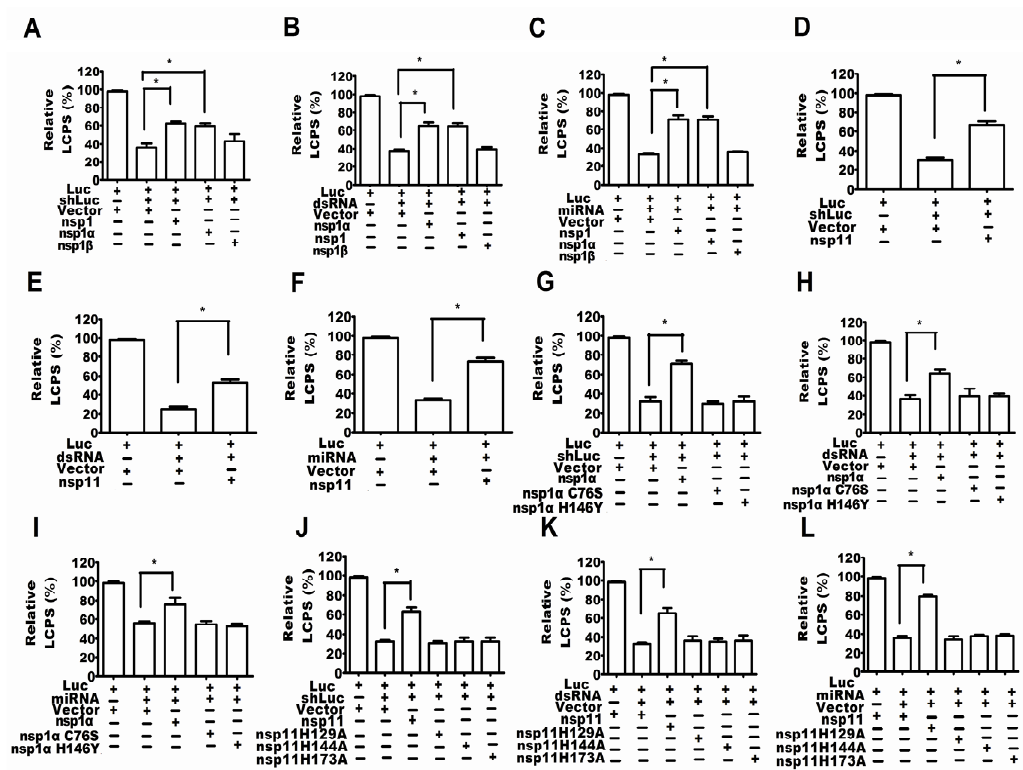
Figure 5. PRRSV nsp1 α and nsp11 were the suppressors of RNA-mediated gene silencing (RSS). MARC-145 cells were co-transfected with firefly luciferase expression plasmid, internal control plasmid RLTK, expression plasmid of nsp1,nsp1 α , nsp1 β , nsp1 α C76S, nsp1 α